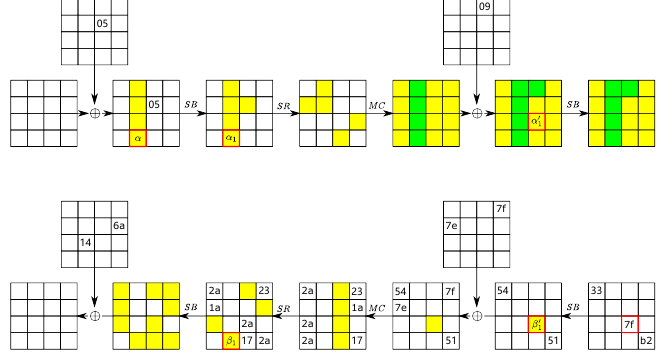
Figure 9: The two middle rounds of the 10-round boomerang attack in the model RTK2